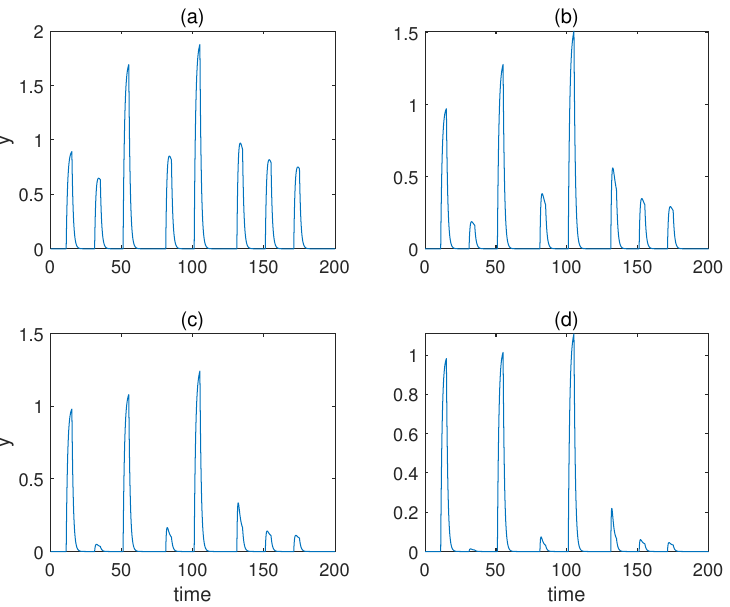
Figure 8. The concentration of molecule y under various Hill coefficients a for the adjusted model with forced dissociation. ( a – d ) Results when a = 1,2,3,4. α yx = 4, α yz = 1, α ux = 0.6, α vx = 1, β u = 0.1, β v =